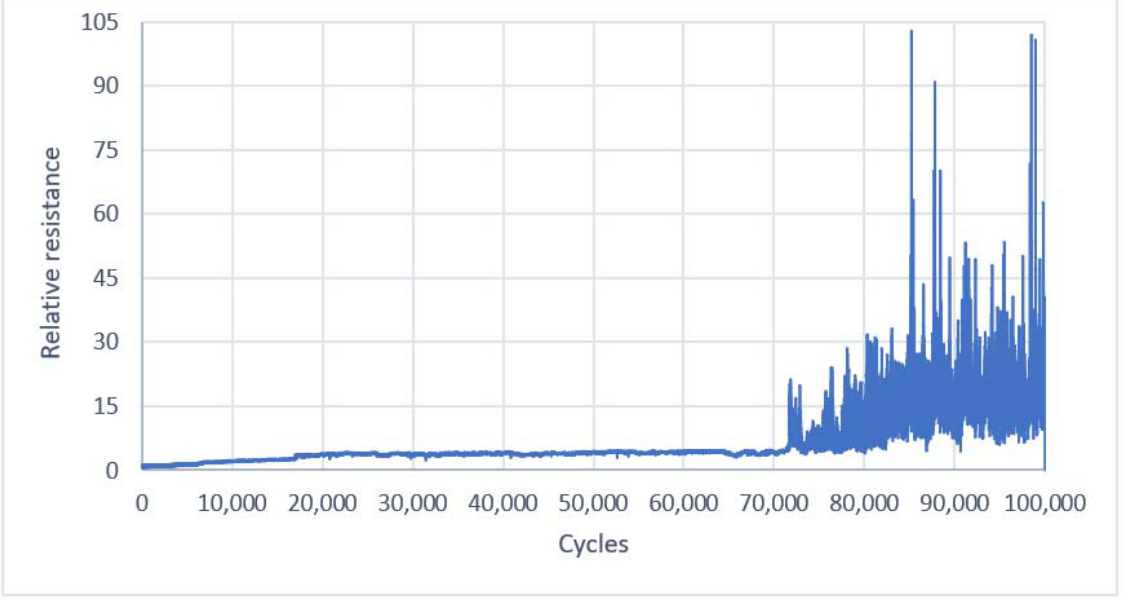
Figure 9. Average relative resistance of the electroconductive strips versus bending cycles for a 3050-525/Laird electro- conductive fabric.